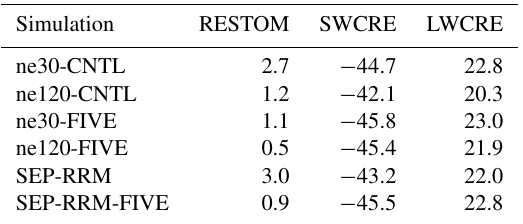
Table 4. Top-of-atmosphere radiation budgets for the simulations performed. All units are given in watts per meter squared (Wm − 2 ). Note that LWCRE is for longwave cloud radiative